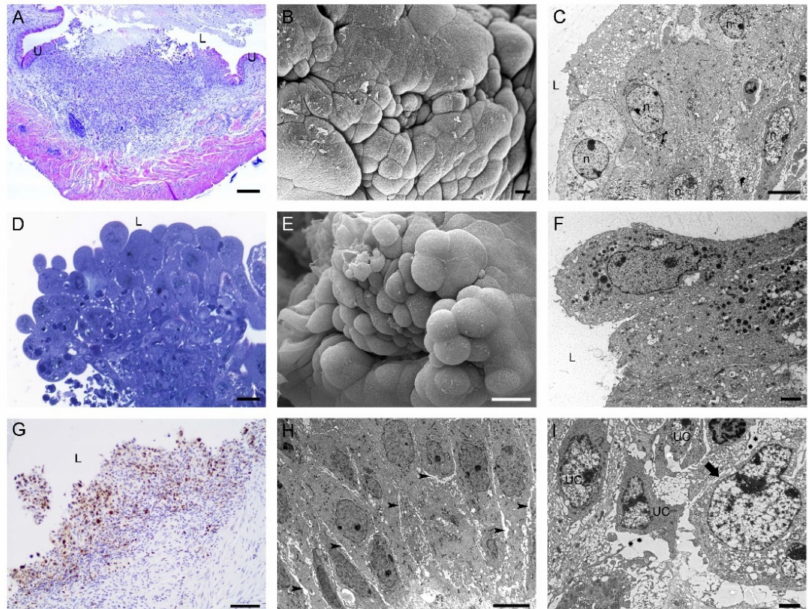
Figure 5. Characteristics of tumors developed in mouse urinary bladders 3 weeks after intravesical application of MB49-GFP cancer cells. Histological and ultrastructural features of sessile bladder tumors in a ( A ) histological section (H&E staining), ( B ) scanning electron micrograph, and ( C ) transmission electron micrograph. Histological and ultrastructural features of papillary tumors in a ( D ) histological section (H&E staining), ( E ) scanning electron micrograph, and ( F ) transmission electron micrograph. ( G ) Bladder tumor with numerous Ki67-positive cells. Nuclei were stained with hematoxylin. ( H ) Ultrastructure of tumor urothelial cells with enlarged intercellular spaces (arrowheads) between them. ( I ) Ultrathin section with the regions of degraded basal lamina (asterisks) under tumor urothelial cells (UC). Arrow denotes an intact part of the basal lamina. U—urothelium; L—lumen of the urinary bladder; n—nucleus. Bars are 200 µ m ( A ); 10 µ m ( B ); 6 µ m ( C , H ); 20 µ m ( D , E ); 2 µ m ( F , I ); and 100 nm ( G